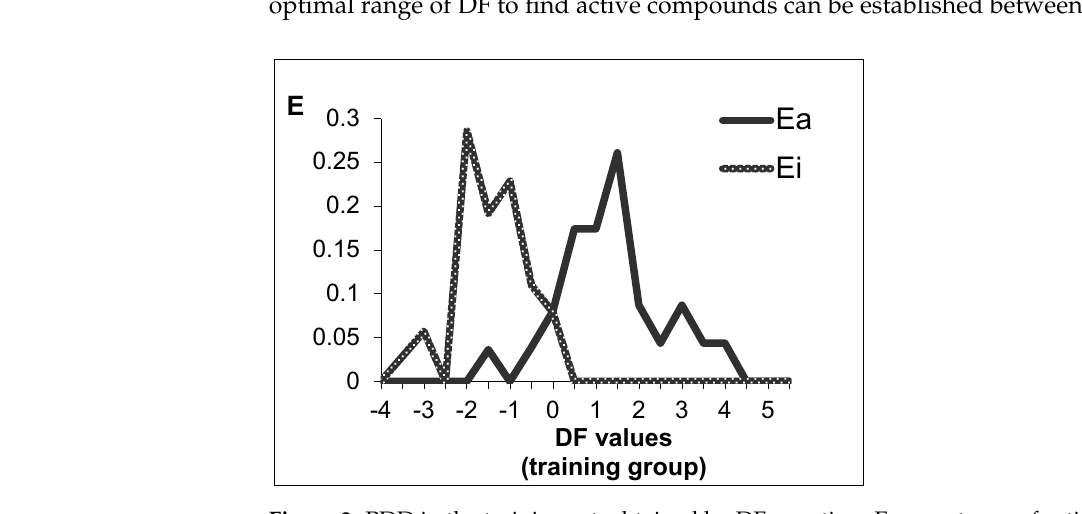
Figure 2. PDD in the training set, obtained by DF equation. E, expectancy of activity or inactivity; black line, active group; grey line, inactive group.